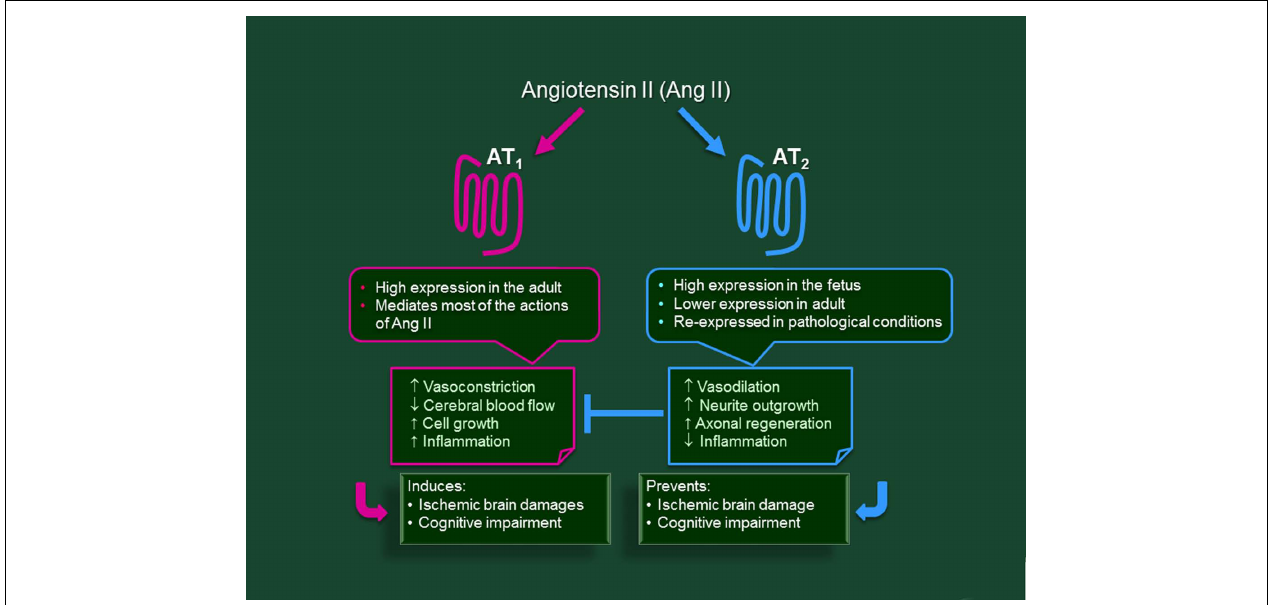
FIGURE 1 | Summary of the properties and main effects targeted byAT1 andAT2 receptors of angiotensin II in the brain.